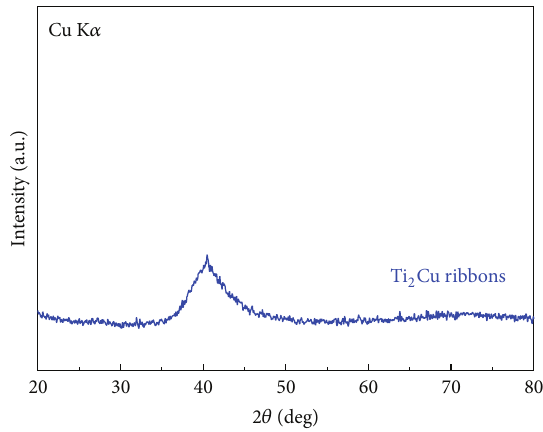
Figure 1: XRD pattern of the as-prepared Ti 2 Cu ribbon sample.